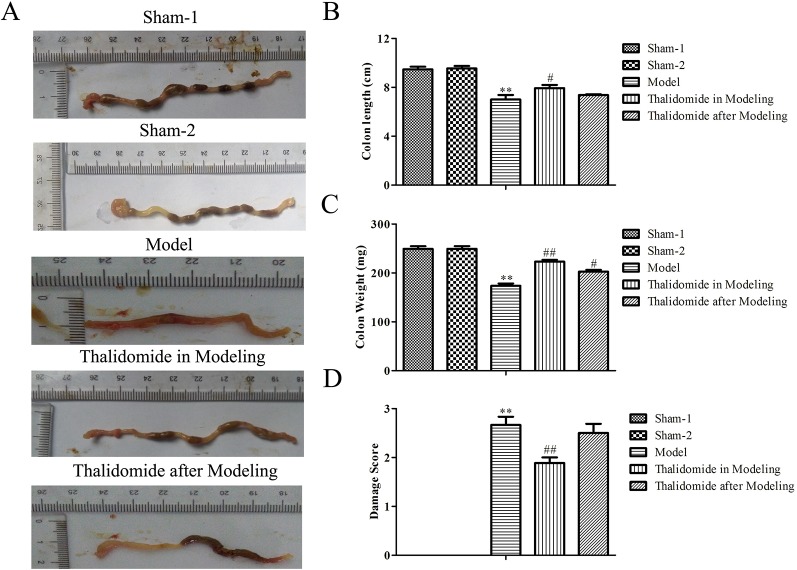
Effects of thalidomide on the colonic weight and length in mice induced with TNBS. The colonic length and weight of mice from different groups were measured, and treatment with thalidomide showed remarkably effects in TNBS-induced alterations in colonic weight, length and macroscopic scores. The results were expressed as the mean ± SD. **P < 0.01 compared with the sham-1 and sham-2 groups; #
P < 0.05, ##
P < 0.01 compared with the model group. (A) Macroscopic appearance of colons from each group. (B) Colon length of each group. (C) Colon weight of each group. (D) Macroscopic score of each group.